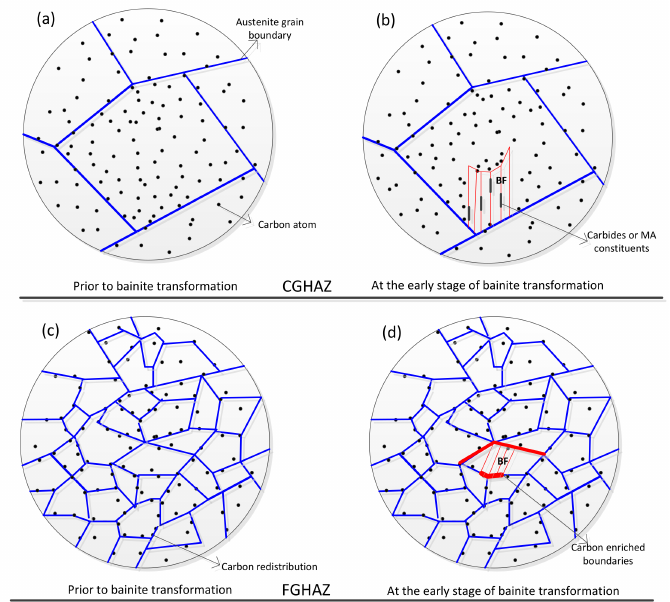
Figure 9. Carbon redistribution in super-cooled austenite before and after the onset of bainite transformation for CGHAZ ( a , b ) and FGHAZ ( c , d